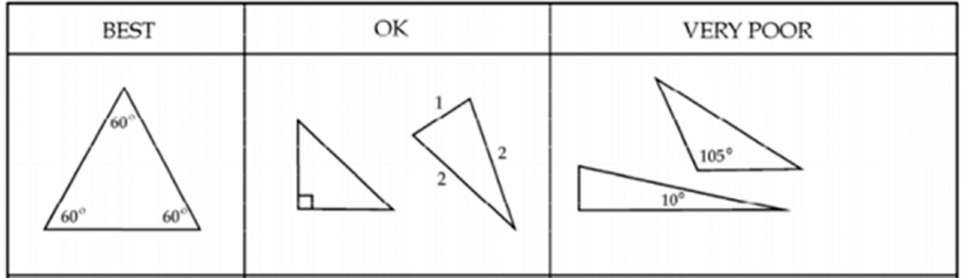
Figure 4. Mesh control. Source: HyperMesh meshing control guide.